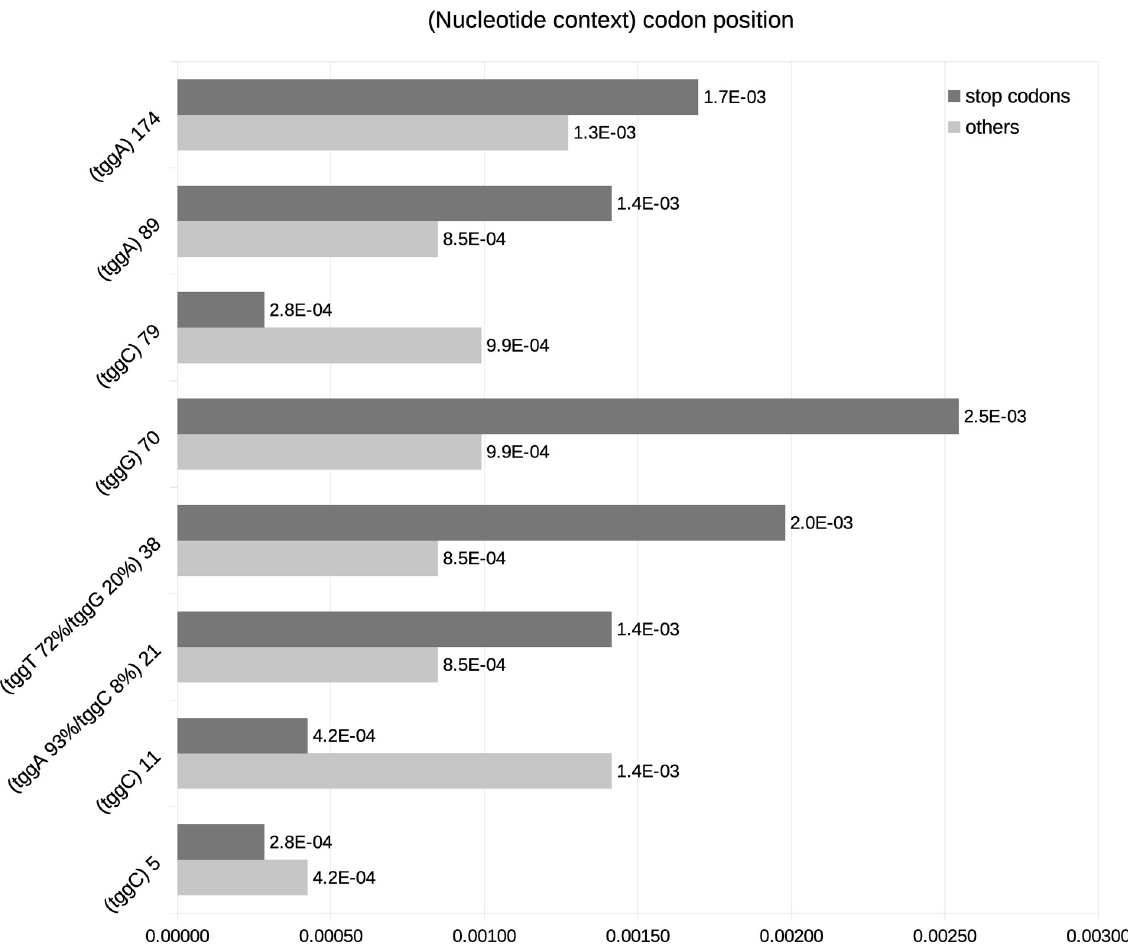
Fig 1. Mutation rates in tryptophan codons of the vif gene of HIV-1. At each tryptophan site (TGG) of the gene vif the number of amino acid changes was estimated. Dark gray horizontal bars indicate the number of changes from TGG to stop codons ( i . e ., TAA, TAG, TGA) and light gray bars represents changes from TGG to any other codons such as AGG, TTG, TCA, etc. The next nucleotide after the TGG is shown in each codon. These nucleotides determine the context target by the human proteins A3 protein (see next figure). Codons 21 and 38 have distinct percentages of a certain nucleotide that is indicated in the